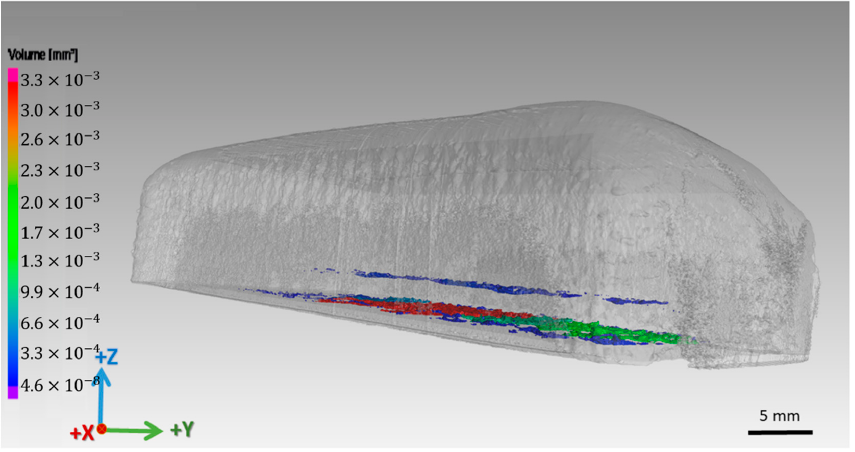
Figure 6. 3D rendering on sample 4 highlighting the appearance of pore clusters, were the most predominant are near the substrate region.